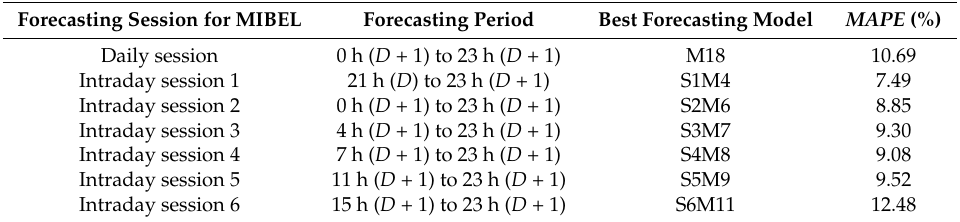
Table 14. The best ISMPF models and the best DSMPF model.